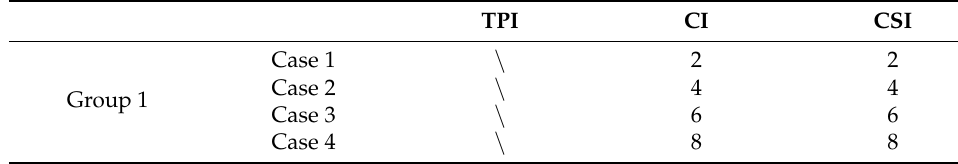
Table 2. Interpolation schemes and the selection of